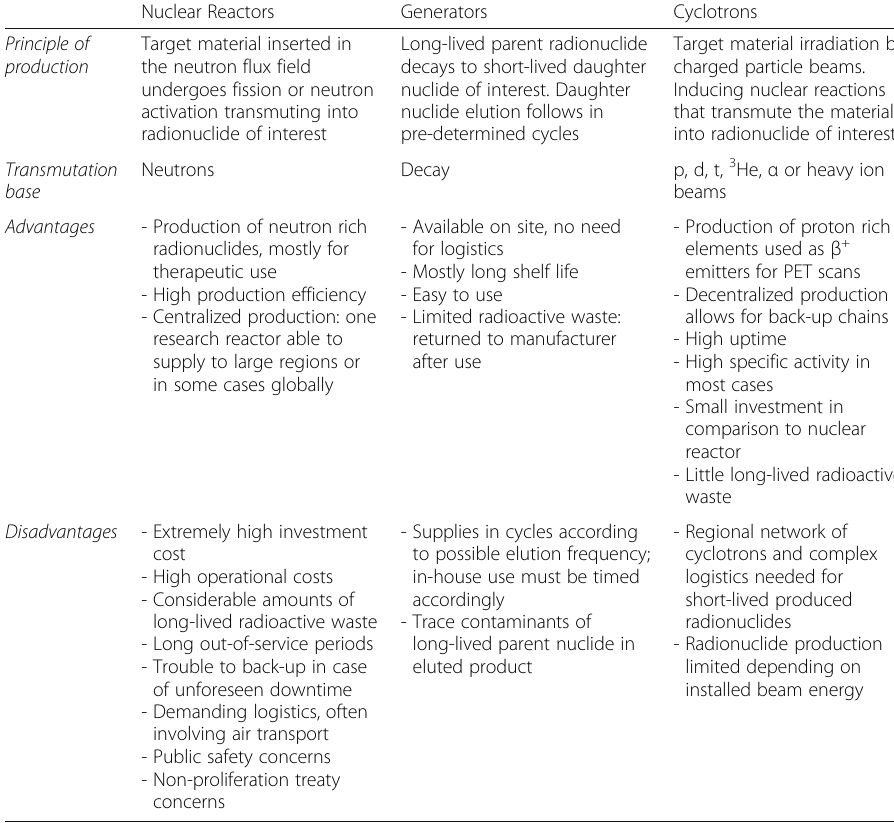
Table 1 Common types of radionuclide sources Nuclear Reactors Generators Cyclotrons Principle of